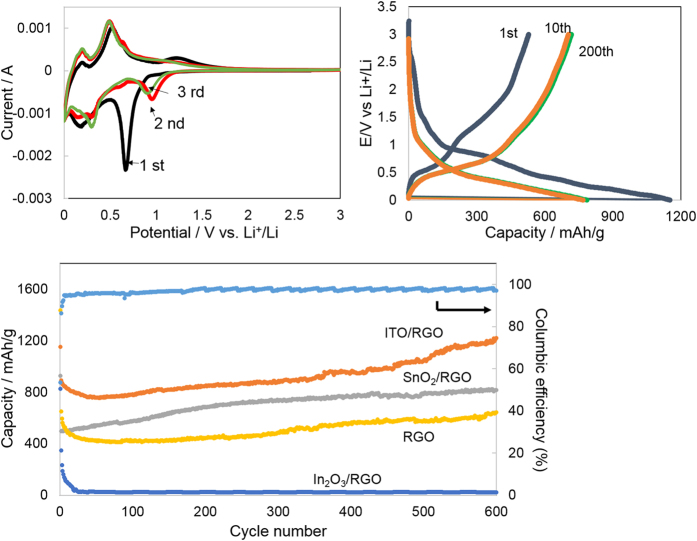
(a) Cyclic voltammograms of the ITO/graphene composite between 0.01 and 3 V vs. Li+/Li at a scan rate of 0.1 mV/s. (b) Galvanostatic charge/discharge profiles of the ITO/RGO cycled at 1st, 10th, 200th between 0.01 and 3 V (vs. Li+/Li) at 1C current density. (c) Cycling performance of ITO/RGO, SnO2/RGO, In2O3/RGO and RGO electrodes and Columbic efficiency of ITO/RGO electrode.